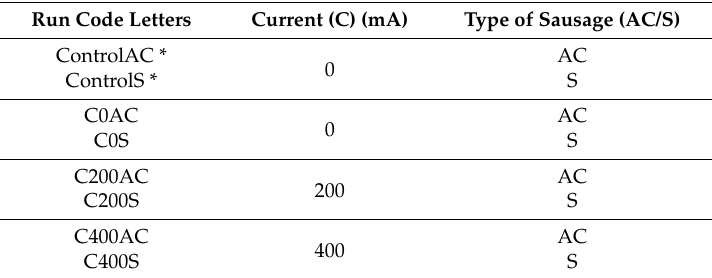
Table 1. Experimental